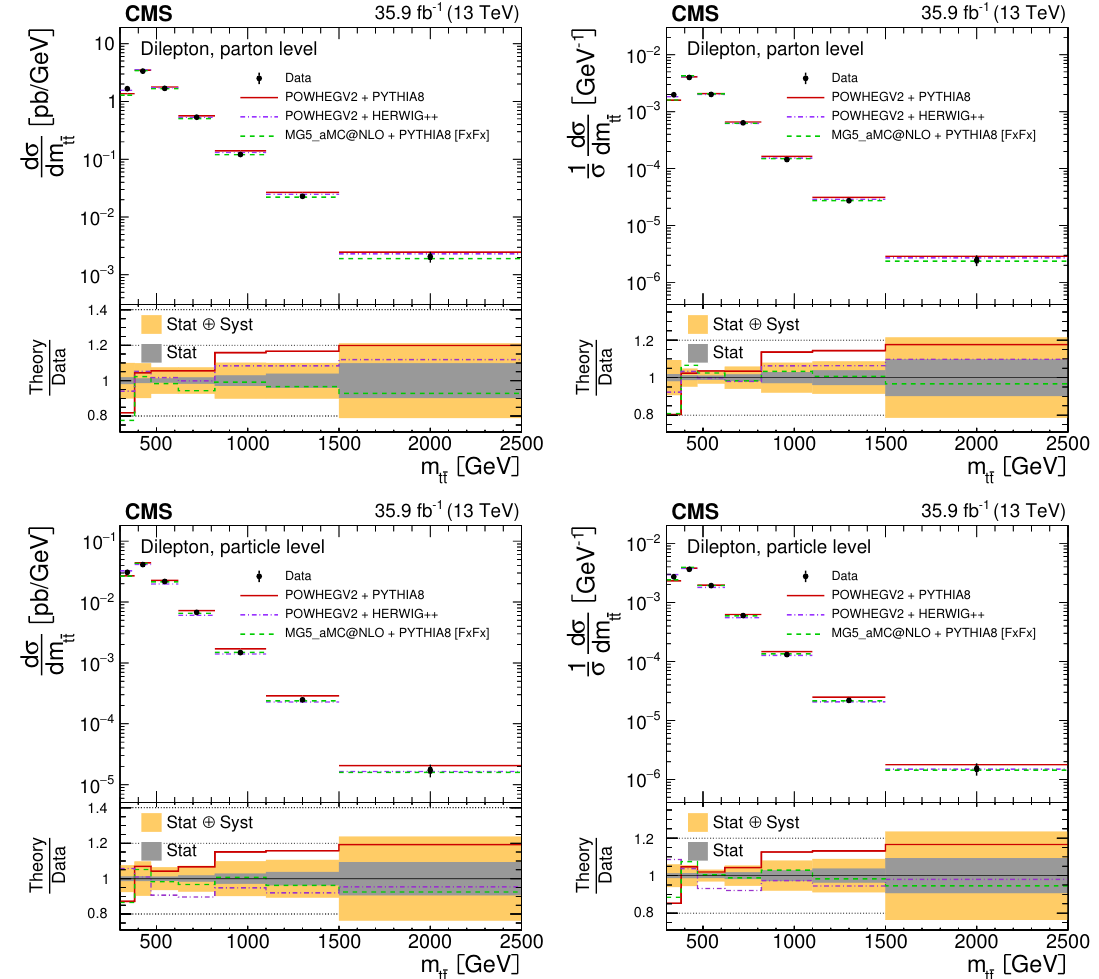
Figure 30 . The di(cid:11)erential tt production cross sections as a function of m data (points) and the MC predictions (lines). The vertical lines on the points indicate the total uncertainty in the data. The left and right columns correspond to absolute and normalised mea- surements, respectively. The upper row corresponds to measurements at the parton level in the full phase space and the lower row to the particle level in a (cid:12)ducial phase space. The lower panel in each plot shows the ratios of the theoretical predictions to the data. The dark and light bands show the relative statistical and total uncertainties in the data, respectively.